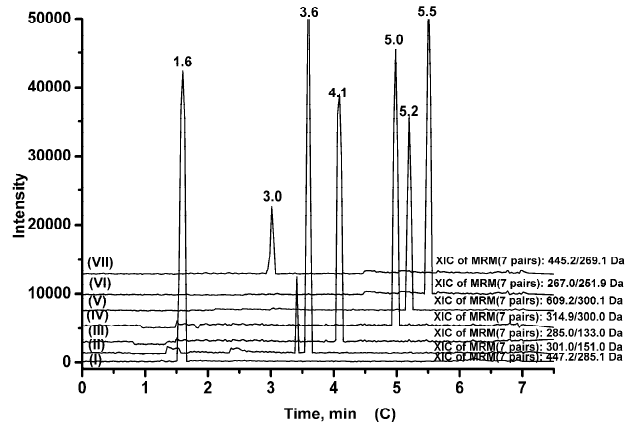
Figure 2. Typical chromatograms of ( A ) blank rat plasma; ( B ) blank rat plasma spiked with six analytes and IS at LLOQ; ( C ) normal group rat plasma sample 2 h after administration of Maydis stigma decoction at a dose of 5.0 g·kg − 1 . Representative MRM chromatograms of cynaroside (I), quercetin (II), luteolin (III), isorhamnetin (IV), rutin (V), formononetin (VI) and baicalin (VII; IS).